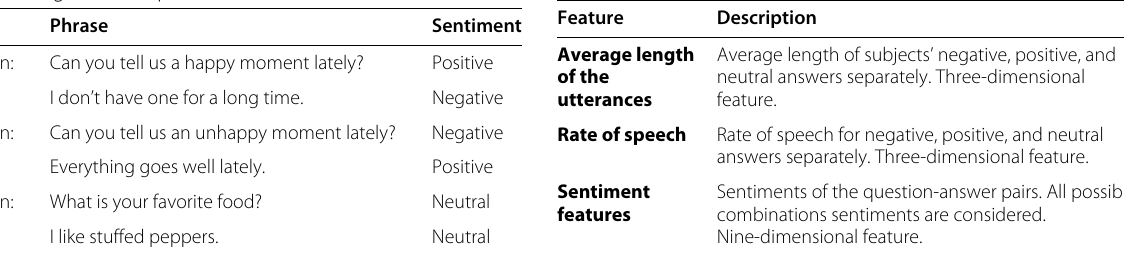
sharper peak around zero and slightly suppressed tails.